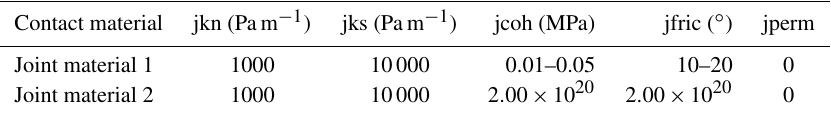
Table 2. Contact properties: applied values for normal stiffness (jkn), tangential stiffness (jks), range of used cohesion values (jcoh), range of used friction angle values (jfric) and permeability